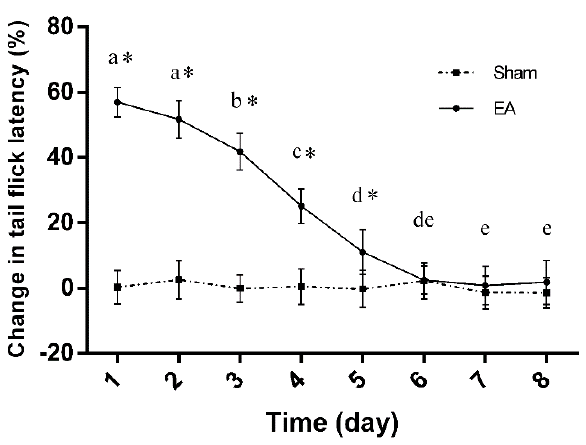
Figure 1. Changes in tail flick latency after repeated electroacupuncture (EA) (Mean ± SD, %, n = 6). EA was given once daily for eight consecutive days. Rats in the sham group were treated with needles left on the acupoints, but without electricity. The significance of differences was calculated by a t -test or a one-way ANOVA. The values with different letters (a–e) within the EA treatment differ ( p < 0.05); * p < 0.05 compared with the sham group within the same day.